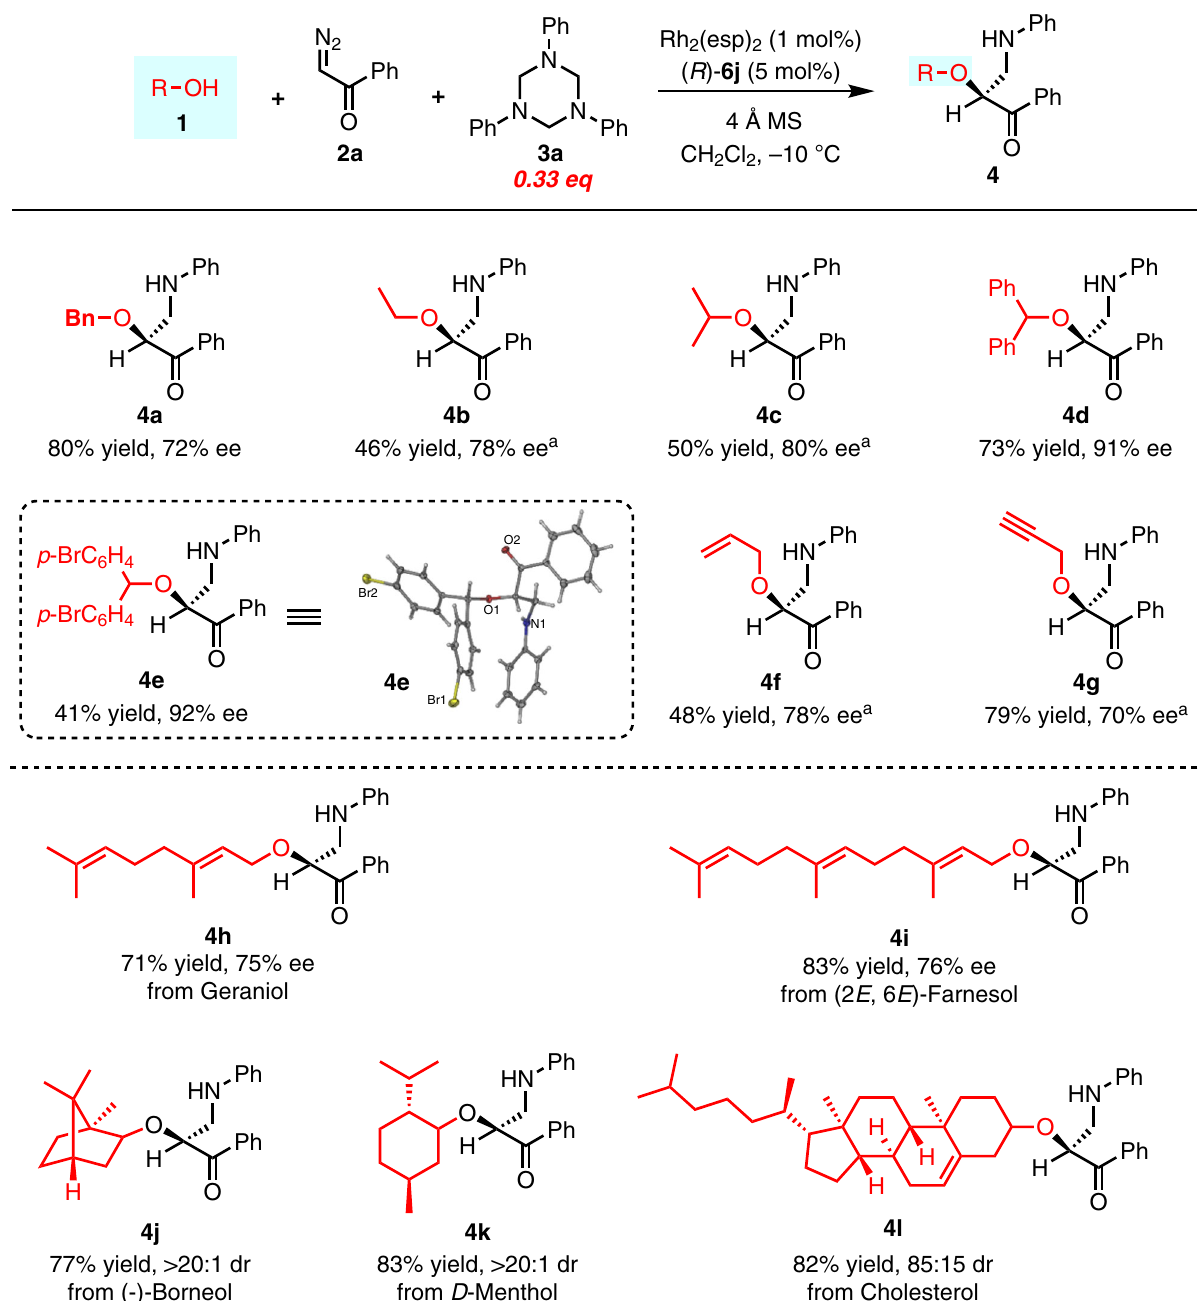
Fig. 4 Substrates scope of different alcohols. Unless otherwise noted, the reactions were run in 0.3 mmol scale of 2a , 1 : 2a : 3a = 1/1/0.33. All yields shown were based on isolated products. Ee values were determined by chiral HPLC analysis. Dr values was determined by 1 H NMR of the crude reaction mixture. a The reactions were run in 0.3 mmol scale of 2a , 1 : 2a : 3 =